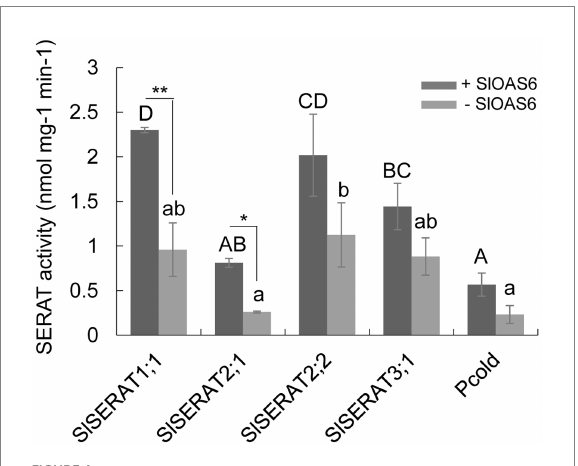
FIGURE 4 Serine acetyltransferase (SERAT) activity assays of the recombinant SlSERAT proteins in the presence (+) or the absence ( − ) of the OASTL protein (SlOAS6). Different letters indicate significant differences calculated by SPSS19.0 software. Letters in the upper case were used to indicate significant differences ( p < 0.05) in the activities of different SlSERAT proteins in the presence of SlOAS6, while letters in the lower case was used to indicate significant differences ( p < 0.05) in the activities of different SlSERAT proteins without the presence of SlOAS6. * p < 0.05 and ** p < 0.01 indicate significant differences in the activity of the same SlSERAT protein with, or without, the presence of the OASTL